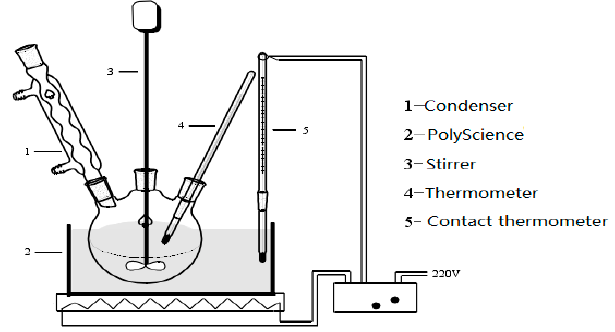
Figure 2. Schematic diagram of experimental apparatus.